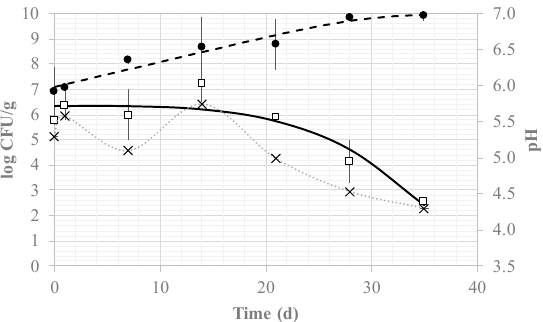
Figure 3. Total bacterial counts, S. aureus survival and pH evolution during Domiati cheese ripening for 35 d storage in control samples. ● Observed growth of total bacterial counts (dashed line corresponds to the fi tt ed Baranyi model); □ Observed survival of S. aureus (solid line corresponds to the fi tt ed Weibull model); × pH evolution.